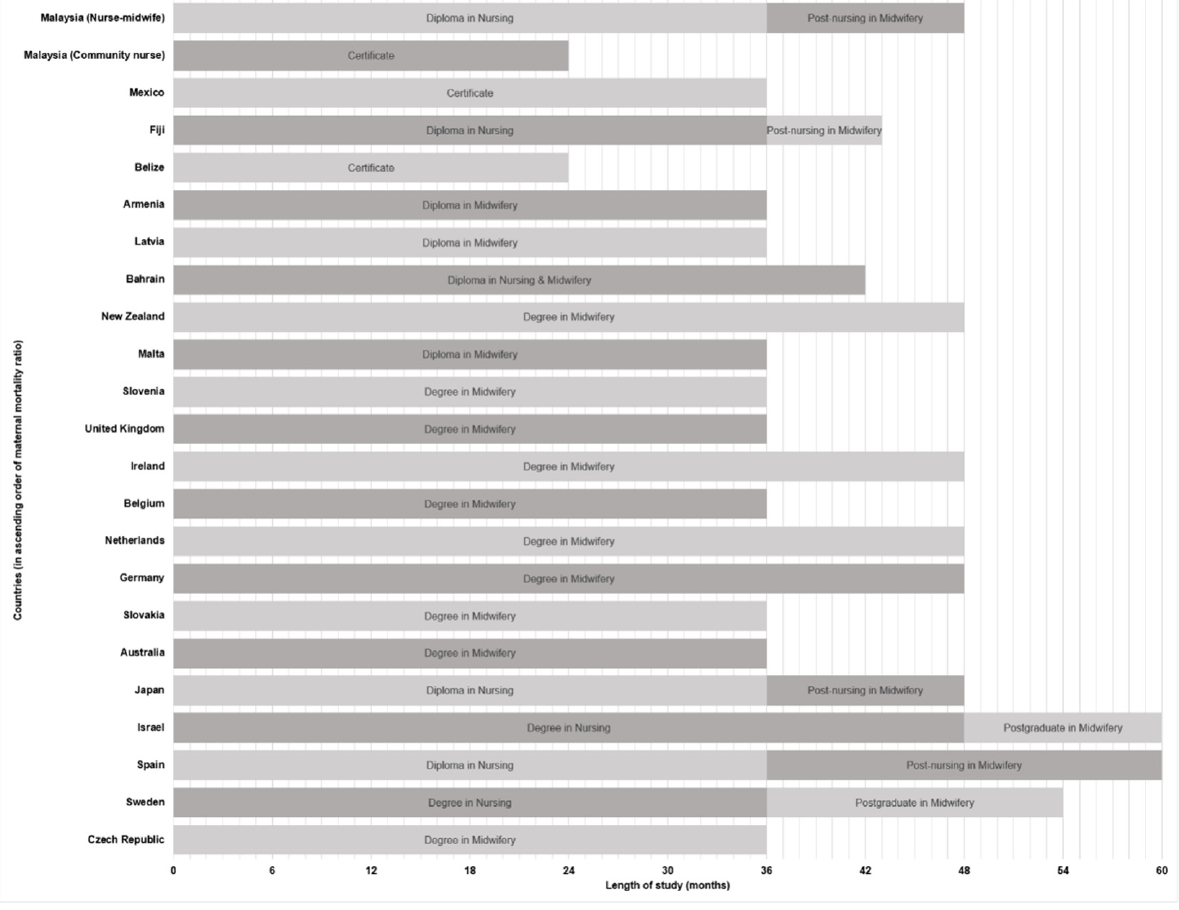
Figure 2. Study duration to become a midwife.